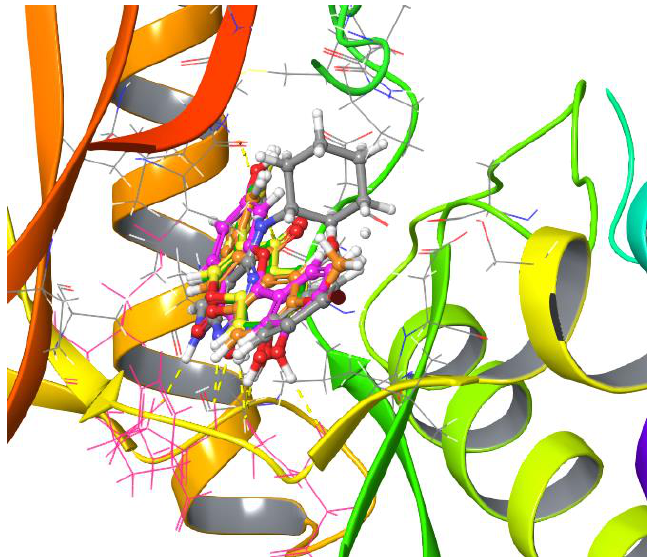
Figure 5. Details of the interaction between the human Mps1 kinase domain and reversine (grey) (PDB ID 5ljj) and its comparison with the anticipated mode of binding to Mps1 of the flavonoids fisetin (pink), genistein (green), daidzein (yellow), and glycitein (orange) as predicted by molecular docking. H-bond interactions are shown in yellow dashed lines. Details of these interactions are also shown in Supplementary Figure S1b–d, respectively.